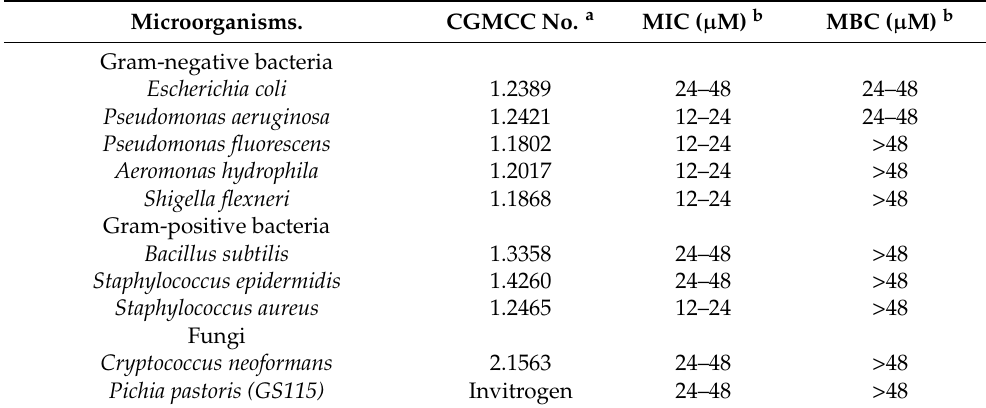
Table 1. Antimicrobial activity of